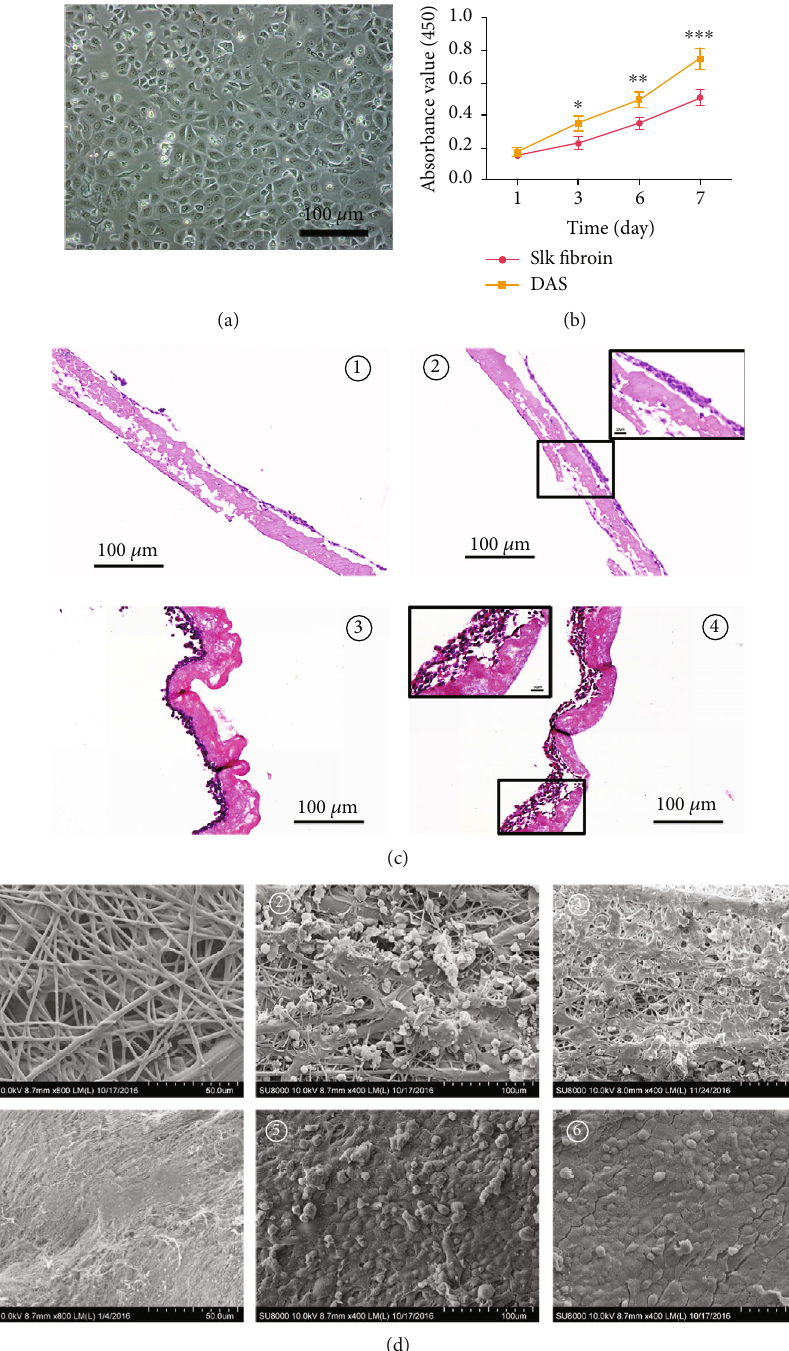
Figure 4: Recellularization capacity of decellularized ADSC sheets in comparison to conventional silk fi broin. (a) Oral mucosal epithelial cell acquisition and culture. (b) Cell proliferation assessment by CCK-8 assay; the decellularized ADSC sheets exhibited a higher proliferative capacity than silk fi broin on days 1, 3, 5, and 7 after cell seeding, and the gap of absorbance value was widening with time; silk fi broin vs. DAS on day 3 after cell seeding ( ∗ P < 0 : 05 ); silk fi broin vs. DAS on day 5 after cell seeding ( ∗∗ P < 0 : 05 ); silk fi broin vs. DAS on day 7 after cell seeding ( ∗∗∗ P < 0 : 01 ). (c) H&E staining observation after cell inoculation: ① silk fi broin recellularization at 3 days of culture, ② silk fi broin recellularization at 7 days of culture — the black box represents a high magni fi cation photograph (400x), ③ decellularized ADSC sheets recellularization at 3 days of culture, and ④ decellularized ADSC sheet recellularization at 7 days of culture — the black box represents a high magni fi cation photograph (400x). (d) SEM observation after cell inoculation: ① morphology of silk fi broin, ② morphology of silk fi broin recellularization at 3 days of culture, ③ morphology of silk fi broin recellularization at 7 days of culture, ④ morphology of decellularized ADSC sheets, ⑤ morphology of decellularized ADSC sheet recellularization at 3 days of culture, and ⑥ morphology of decellularized ADSC sheet recellularization at 7 days of culture. DAS=decellularized ADSC